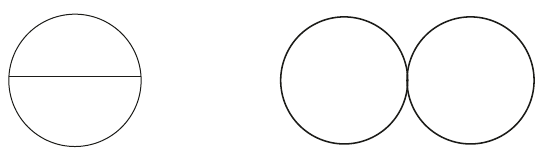
Figure 1 . The unique (up to internal mass assignment) non-factorizable (left) and factorizable (right) two-loop vacuum integral